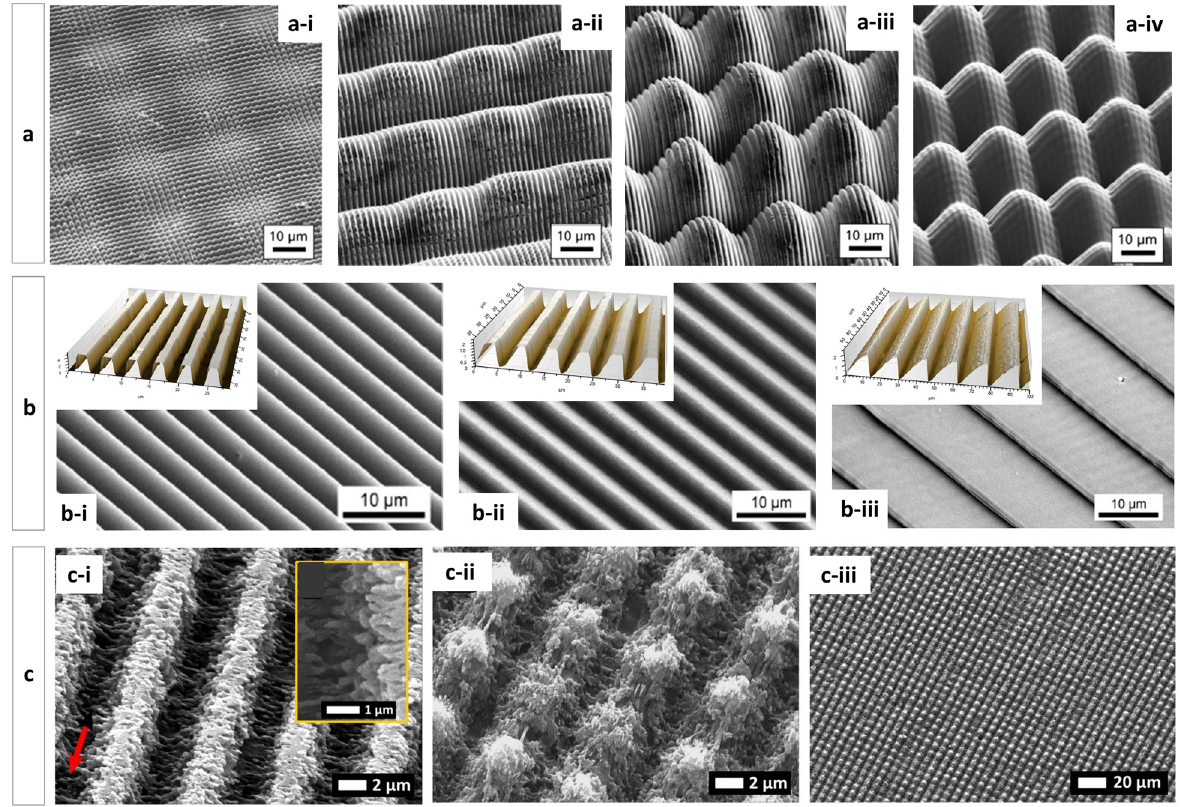
Figure 6: Three series of simple and hierarchical DLIP structures SEM images, portraying: Upper row (a): (a-i) PC-pillar-like (fluence: 0.51Jcm − 2 , N :10pulses),(a-ii)PC-lines-on-perpendicular-line-like(0.51Jcm − 2 ,90pulses),(a-iii)PC-lines-on-pillar-like(1.63Jcm − 2 ,90pulses) and (a-iv) PC-pillars-on pillars-like (1.63 J cm − 2 , 120) in all cases the structured period was 2 µm; middle row (b): (b-i) PI-inclined-lines-0 ° (b-ii) PI-inclined-lines-45 ° and(b-iii)PI-inclined-lines-75 ° ( fl uence:0.51Jcm − 2 , N :10pulses)andconfocaltopography(upperleft);lowerrow(c):(c-i) PI-line-like ( fl uence: 1.34 J cm − 2 , N : 10 pulses), (c-ii, iii) PI-crossline-like ( fl uence: 1.34 J cm − 2 , N 1st pulse : 10, N 2nd pulse : 5). The arrow in (c-i) indicates the polarization vector. These fi gures were adapted from ref. [87] (© 2018 Elsevier B.V.), [88, 95] (Licensed under a Creative Commons